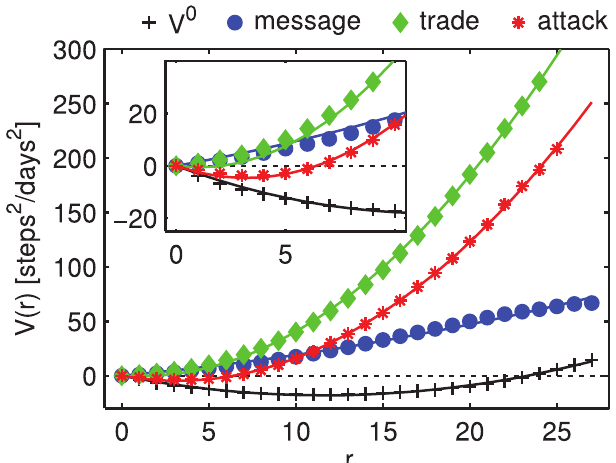
Fig 3. Interaction-specific potentials for messages, trade, and attacks, computed from Eq (3). Solid lines are least-squares fits to a harmonic potential as defined in Eq (4). V 0 is a result of the background motion of non-interacting pairs of players. The inset is a blow-up for small distances. Clearly, the potential for attack shows a minimum at r attack * 3. For all fits (lines) the explained variance is R 2 > 0.99.